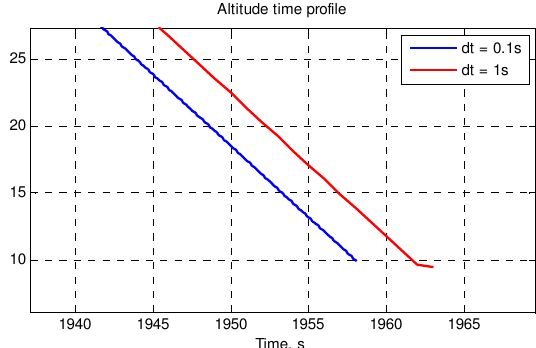
Fig 22. Altitude profiles at end of the mission, illustrating the actual difference caused by different time steps of the ODE4 integration The relative error of the simulated mission duration was between dt=0.1 and dt=1 sec: ε = 0.20 rel